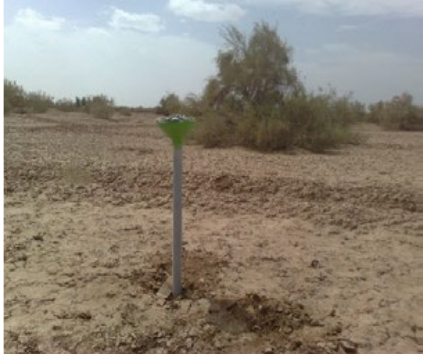
Fig. 2. Ash ( Fraxinus excelsior ) Fig. 3. Specimen of the dust Fig. 2: Ash ( Fraxinus excelsior )